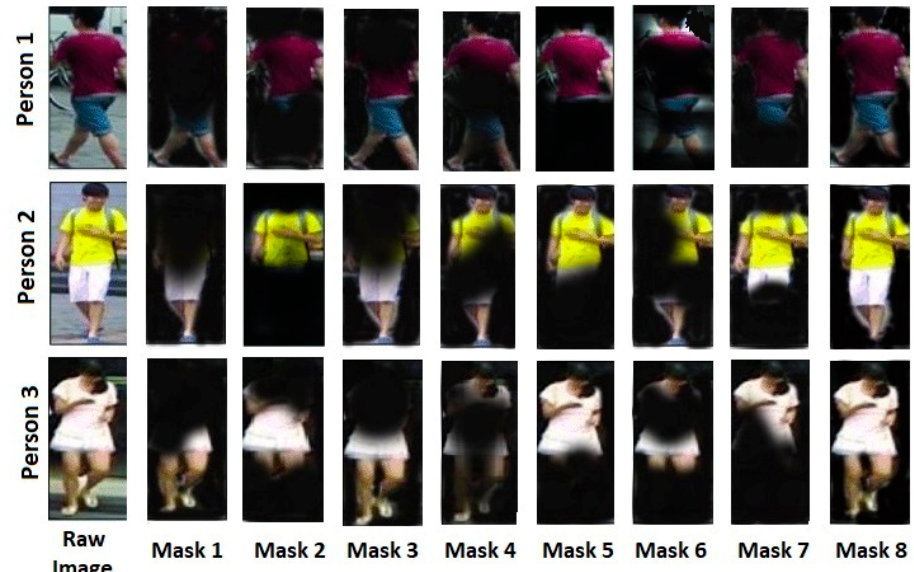
Figure 6. Some examples of applying the proposed person’s body segmentation procedure: ( a ) orig- inal images, ( b ) body mask generated from the Mask R-CNN, ( c ) body mask generated from the enhanced Mask R-CNN using the GrabCut algorithm, and ( d ) the final detected person’s body.